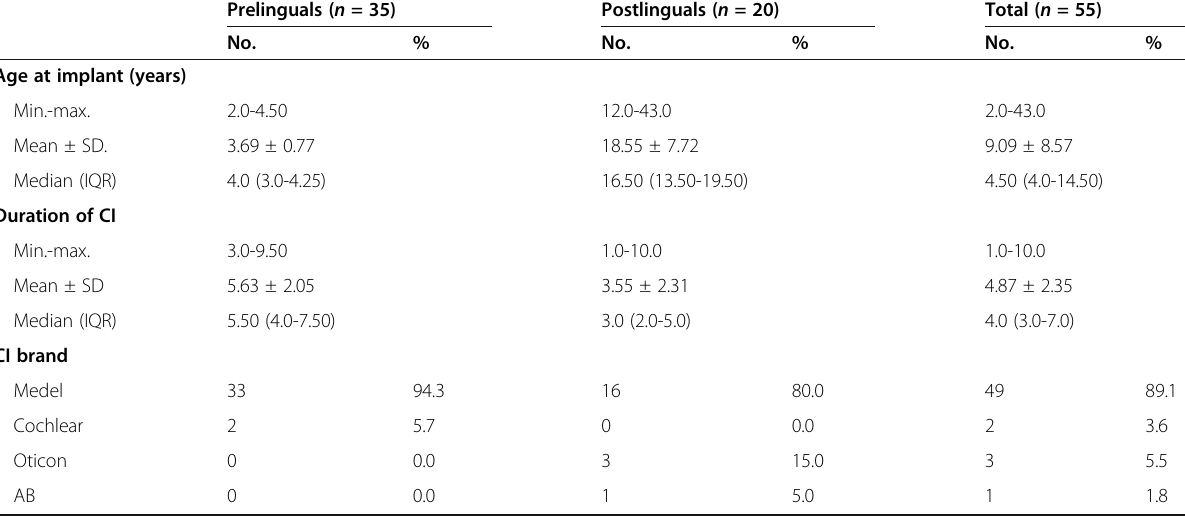
Table 2 Distribution of the studied cases according to age at implant, duration, and CI